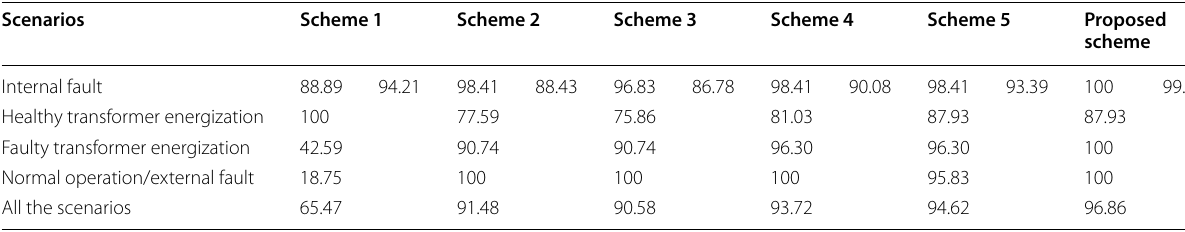
Table 3 Comparison results of classification accuracy (%) Scenarios